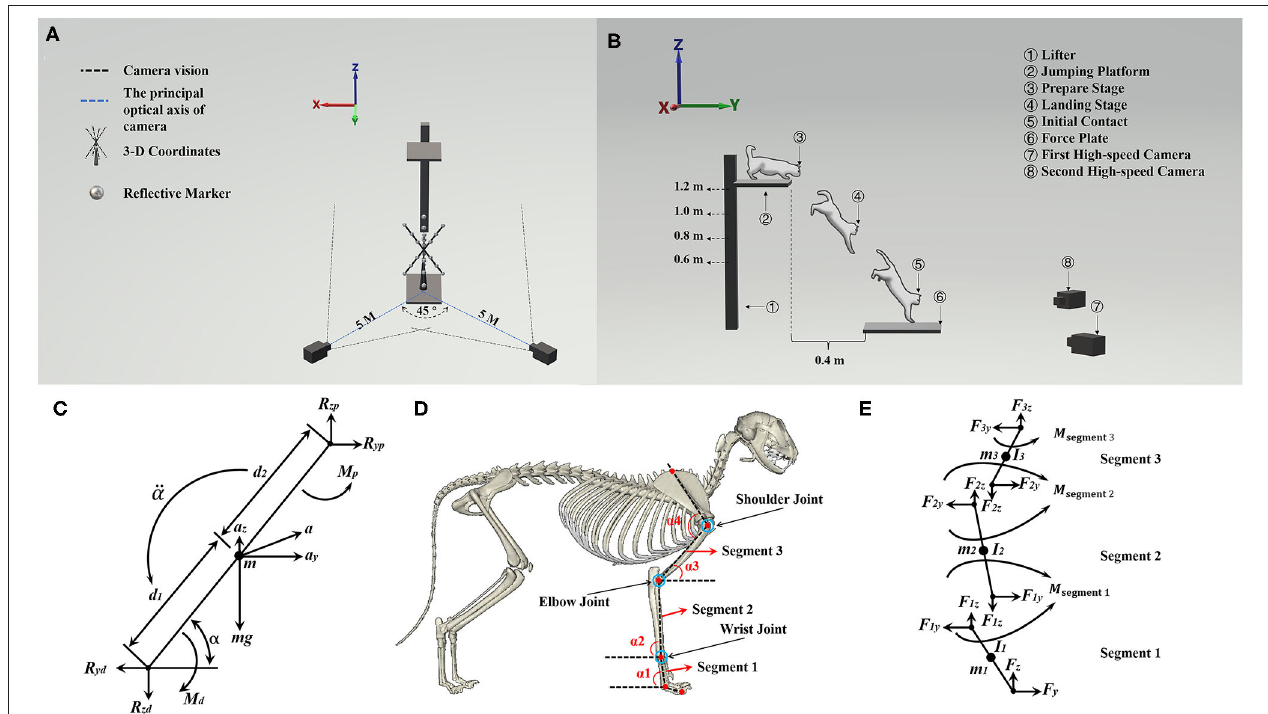
FIGURE 1 | (A) Illustration of the position of two high-speed cameras and 3-D coordinates. (B) Illustration of cat landing procedure from the ready position to initial forelimbs contacting the ground; it also shows the position between the jumping platform and the force plate. (C) The complete free-body diagram of a single forelimb segment, shows reaction and gravitational forces, net moments of force, and all linear and angular accelerations. (D) Illustration of the position of red marker points on the forelimbs of cats ( α 1 , α 2 , and α 3 were used to calculate the joint moment, α 4 is the shoulder joint angle), and the red marker point with a blue circle shows the bone marking the position of the wrist, elbow, and shoulder joint. (E) Freebody diagrams of the three rigid links, which include the joint reaction forces acting on each joint and the segment